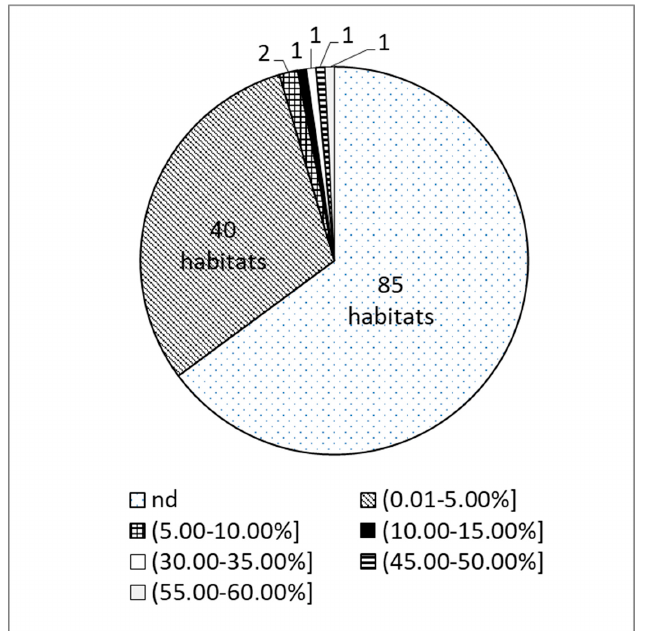
Figure 1. Thymus pulegioides habitats ( n = 131) with different α -terpinyl acetate percentages (nd— α -terpinyl acetate not detected). The map of α -TA distribution between investigated T. pulegioides habitats demon- strated increasing trend of α -TA from the western to the eastern part of Lithuania (Figure 2). Sixty percent of T. pulegioides habitats, in which α -TA was found, were located in slopes with southern, southwestern, south-eastern, and eastern exposures. Calculated Spearman‘s correlation coefficient ( r = 0.66, p < 0.05) demonstrated positive tendency between α -TA amount and the size of these slopes: the higher percentage of α -TA was found in habitats located in southern, southwestern, southeastern, and eastern slopes with higher inclines. It was observed that phenolic carvacrol was the most common compound of T. pulegioides essential oils. Though, the demonstrated carvacrol isomer thymol amount was about 5.5 times lower than carvacrol (Table 2). Additionally, the mean amount of acyclic monoterpene alcohol geraniol was 2.7 times lower than carvacrol (Table 2).